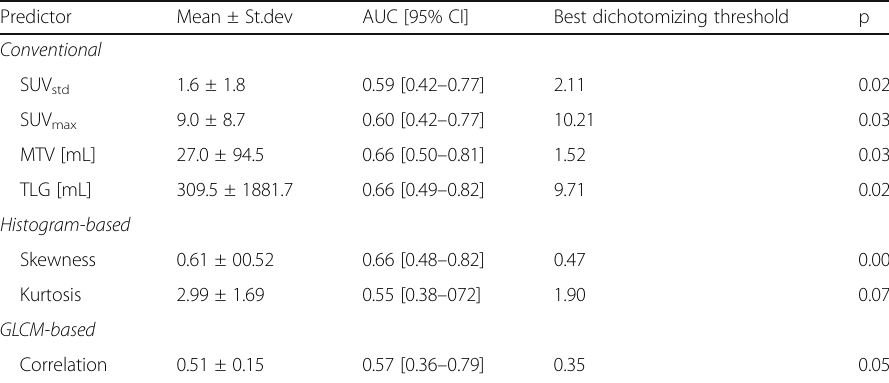
Table 4 Summary of statistically significant predictors Predictor Mean ± St.dev AUC [95% CI] Best dichotomizing threshold p